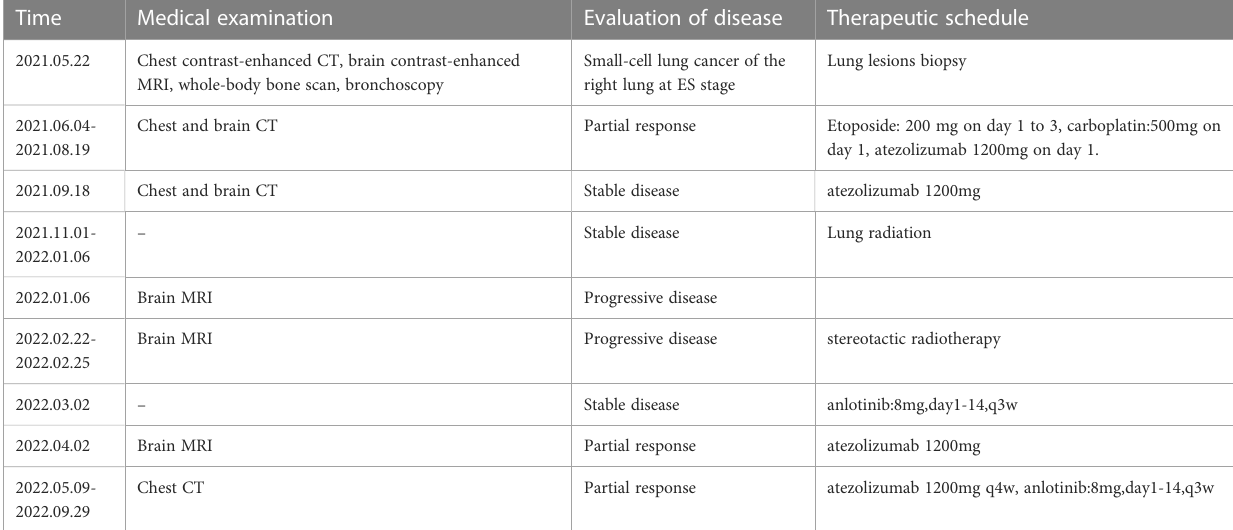
TABLE 1 Timeline of the